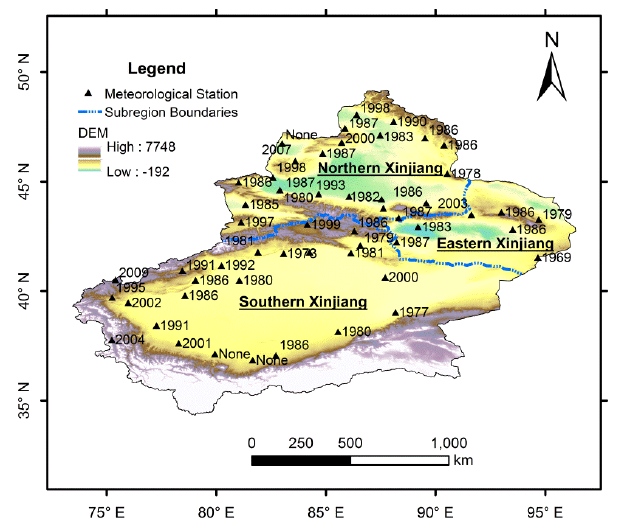
Figure 10. Spatial distribution of the turning points of annual precipitation in Xinjiang.